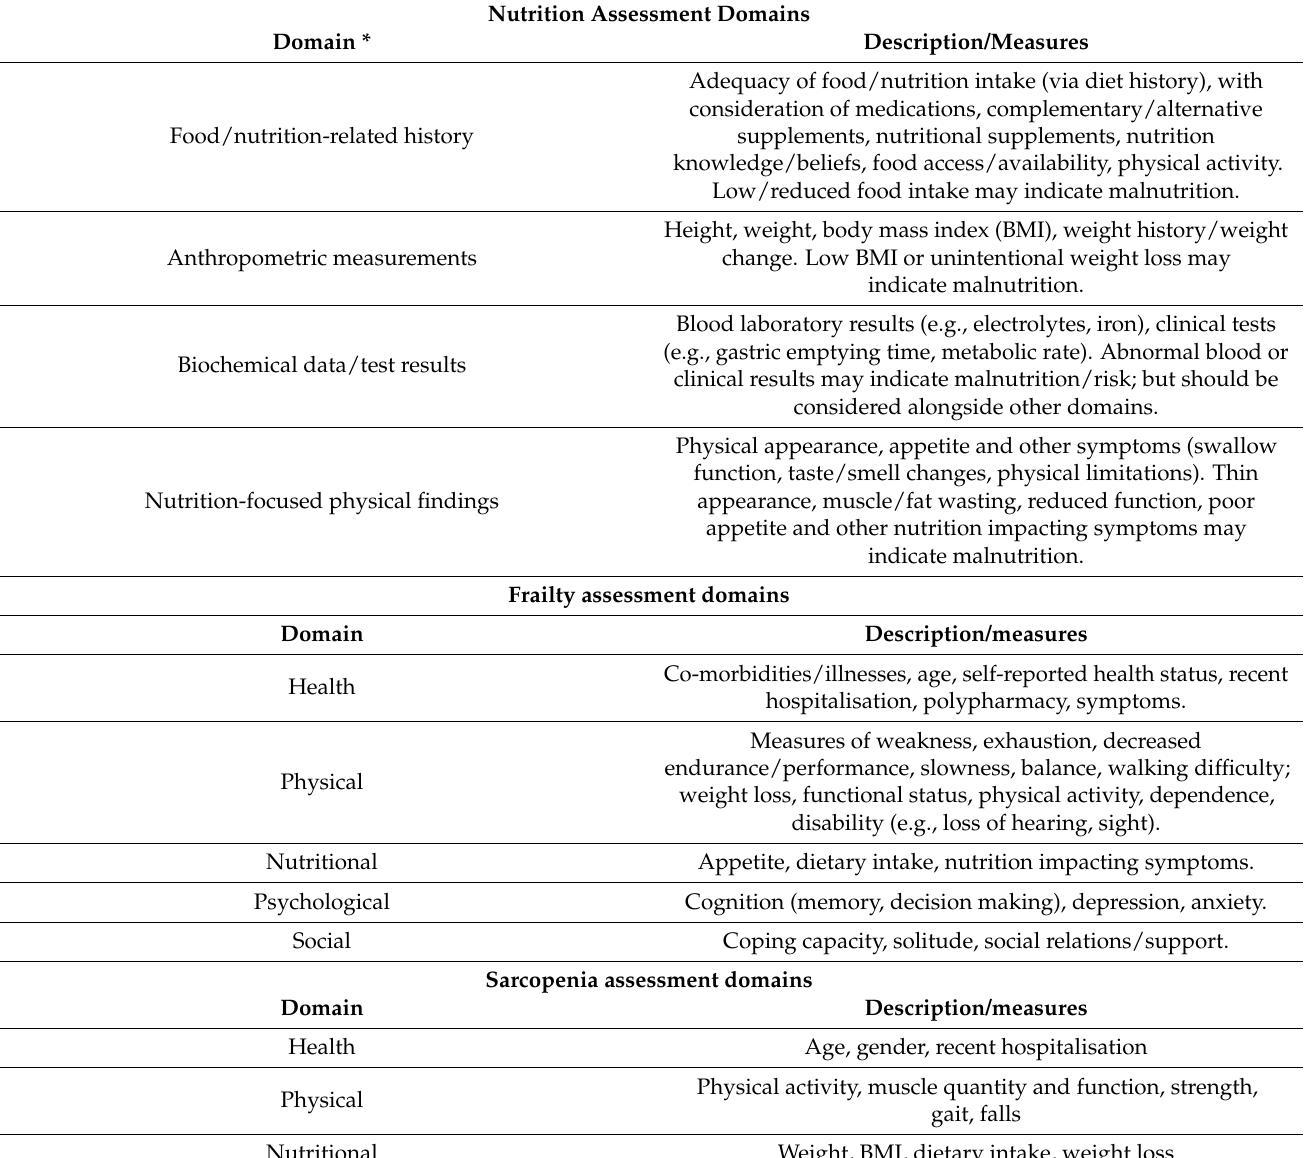
Table 3. Nutrition assessment domains and tools (partially adapted from NCP